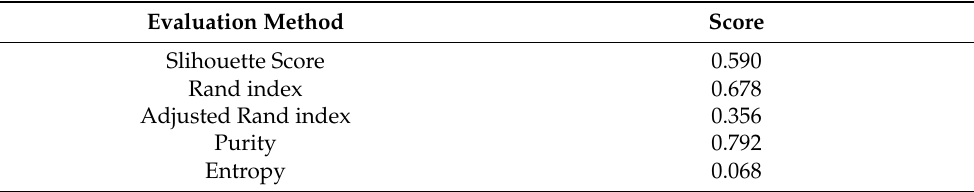
Table 3. The evaluation results for the event clustering.